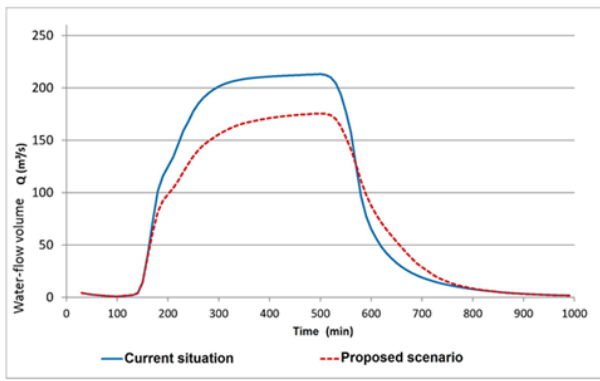
Fig. 5 . Hydrographs of the Perequê-Acu (above) and Mateus Nunes (below) rivers intersecting